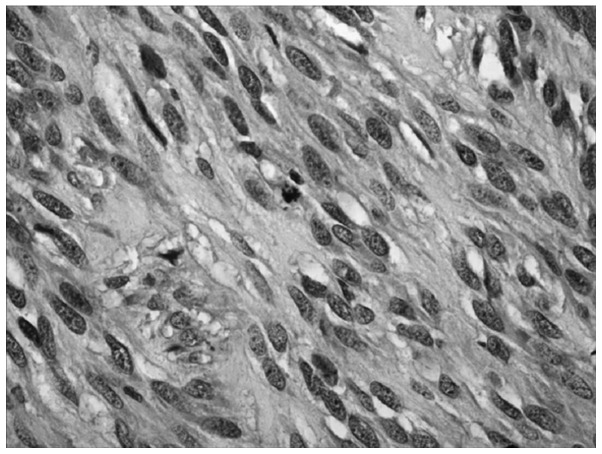
The expressed CD34.